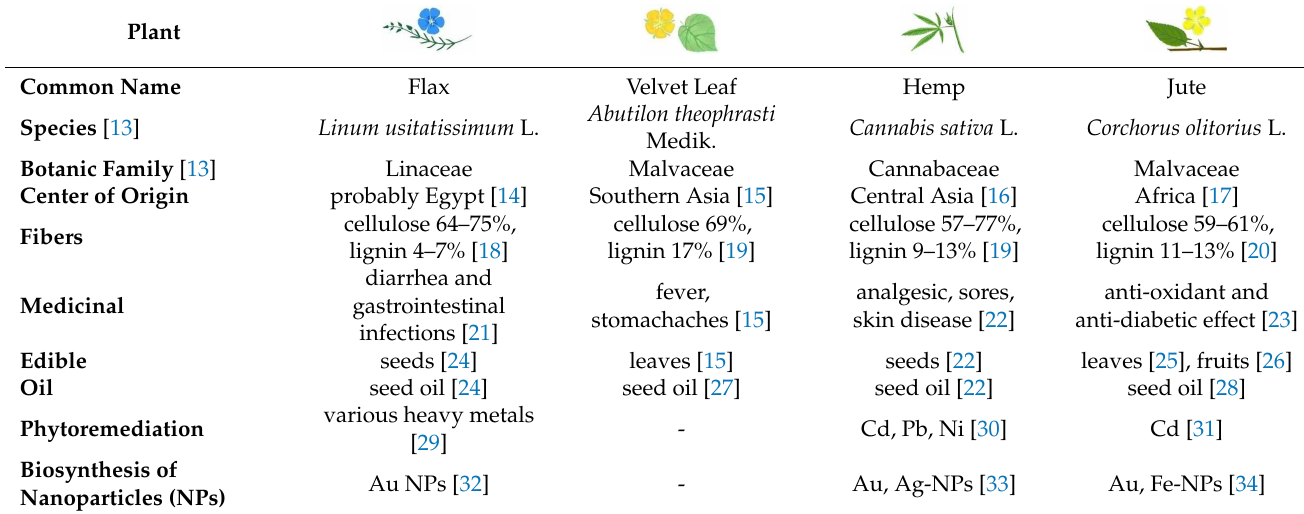
Table 1. Primary and secondary importance of some commonly cultivated fiber species.